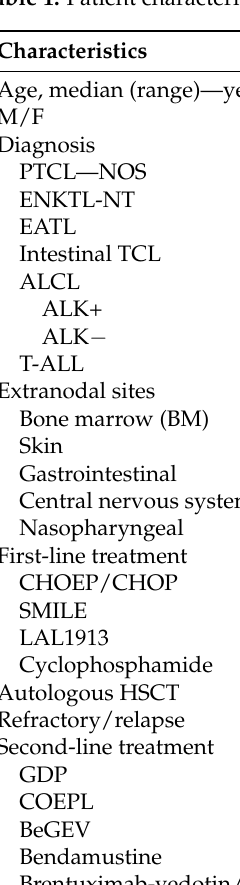
Table 1. Patient